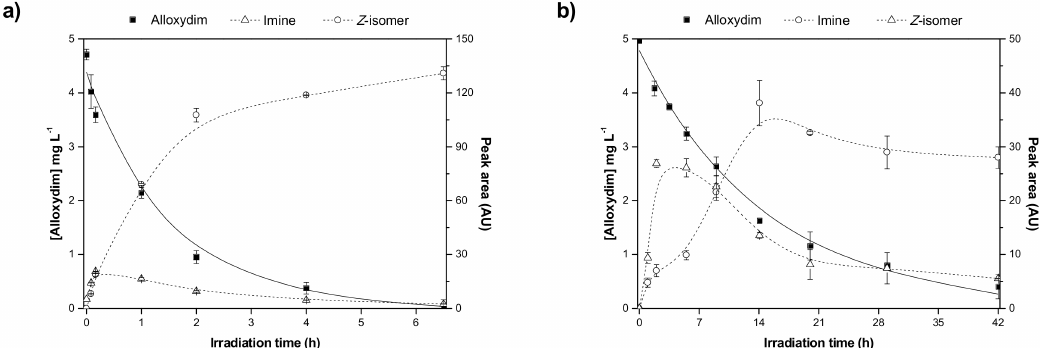
Figure 1. Kinetic evolution of the photodegradation products (open symbols and dotted lines) formed during the irradiation of alloxydim (filled symbols and solid line) on ( a ) carnauba wax films and ( b ) sandy loam soil.